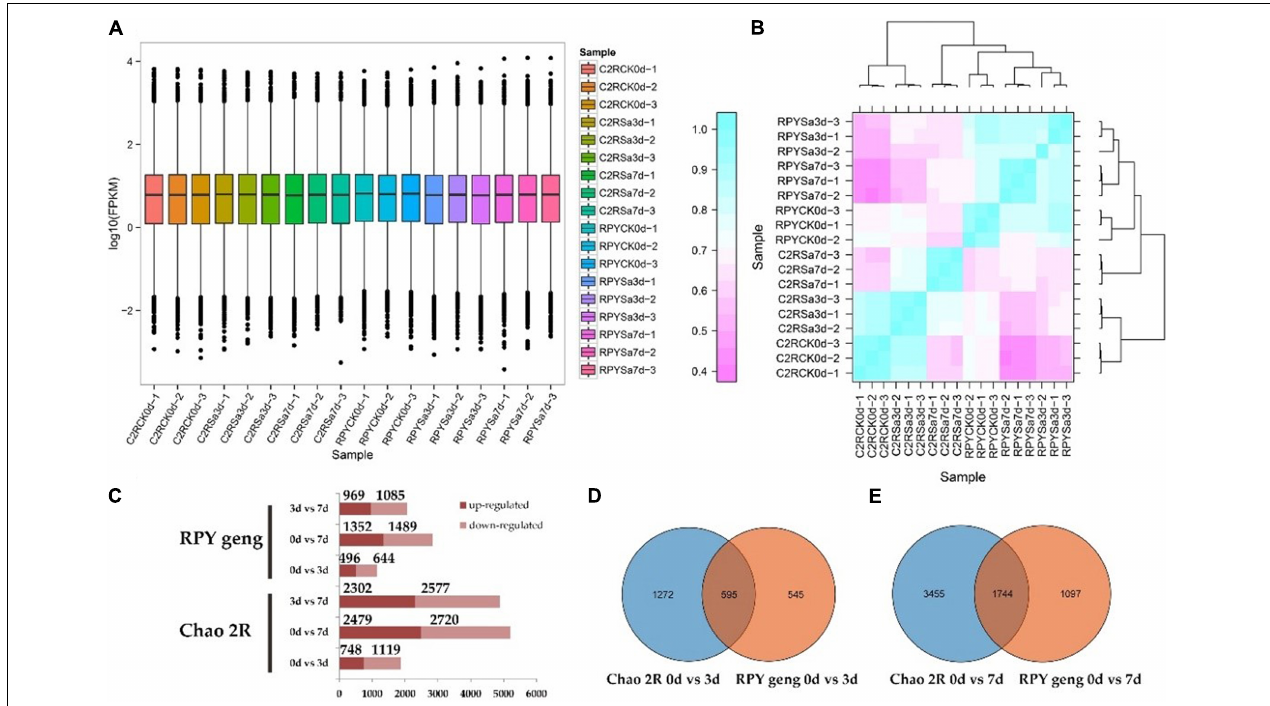
FIGURE 2 | Sequencing data and differentially expressed genes (DEGs) results. (A) FPKM box diagram of all tested samples. (B) Heatmap of Pearson correlation coefficient for all tested samples. (C) Statistics results of DEGs in all comparison combinations. (D,E) The venn analysis of DEGs between Chao 2R and RPY geng in 3 or 7 days after stress